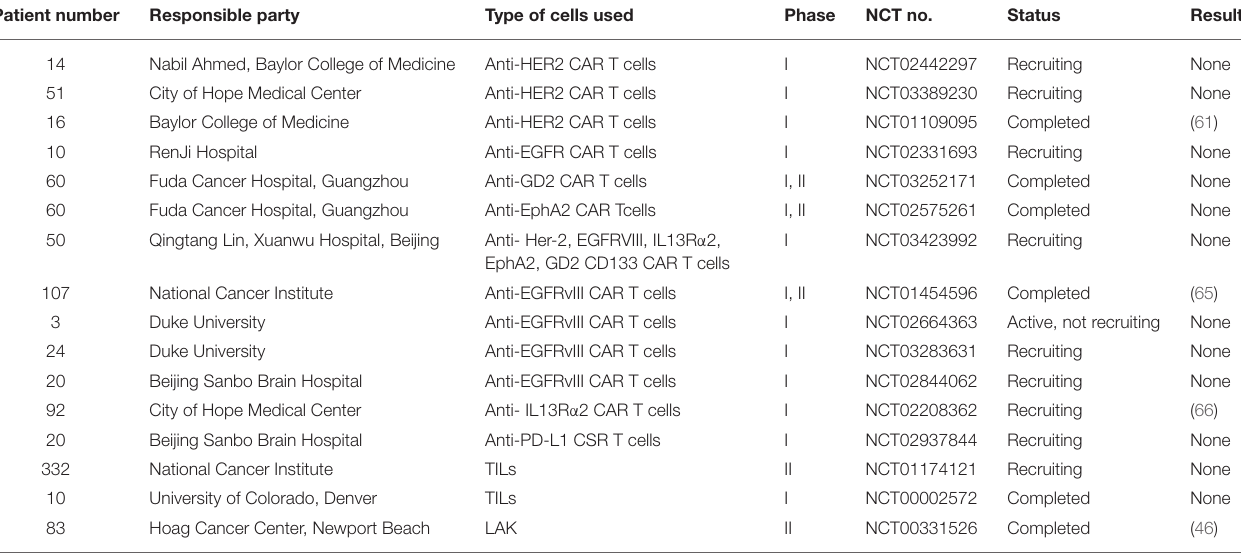
TABLE 1 | Clinical trials of adoptive cell therapy in patients with glioblastoma. Patient